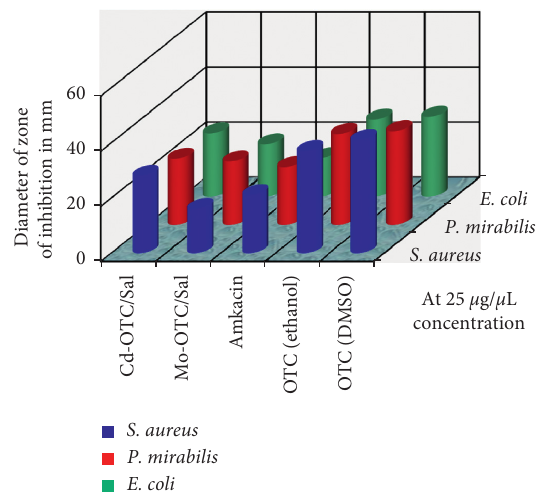
Figure 9: Bar graph showing antibacterial sensitivity at 25 μ g/ μ L concentration.